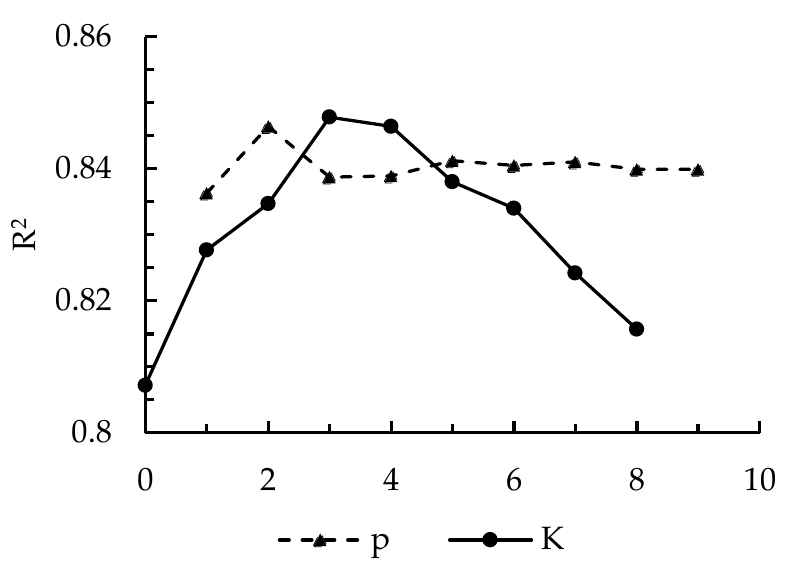
Figure 8. Selection of KNN hyperparameters.